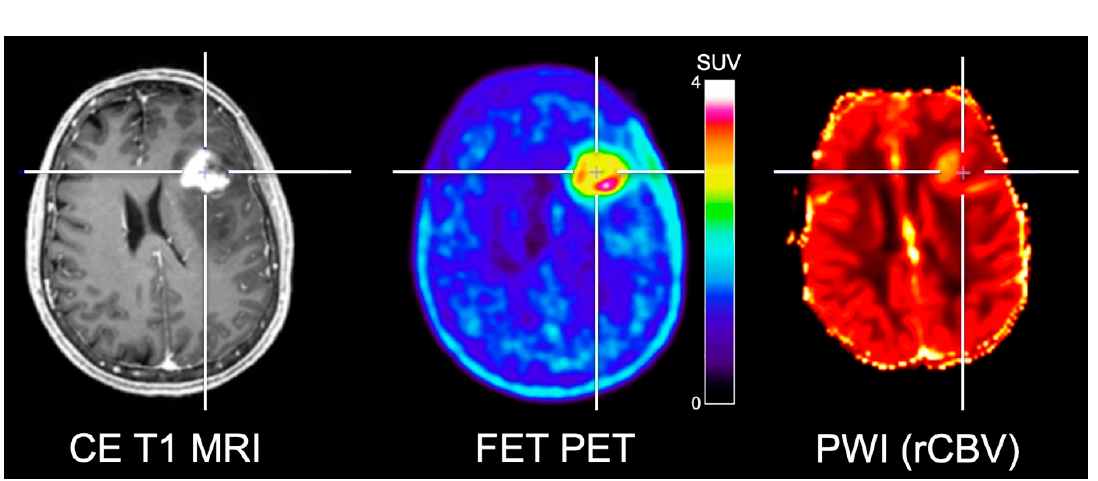
Figure 2. Simultaneously acquired contrast-enhanced (CE) T1-weighted MRI, FET PET and relative cerebral blood volume (rCBV) obtained from PWI in a patient with neuropathologically confirmed glioblastoma. FET PET identifies metabolically active tumor areas without an increased rCBV. Image courtesy of Christian Filss, Institute of Neuroscience and Medicine, Forschungszentrum Juelich, Juelich, Germany.